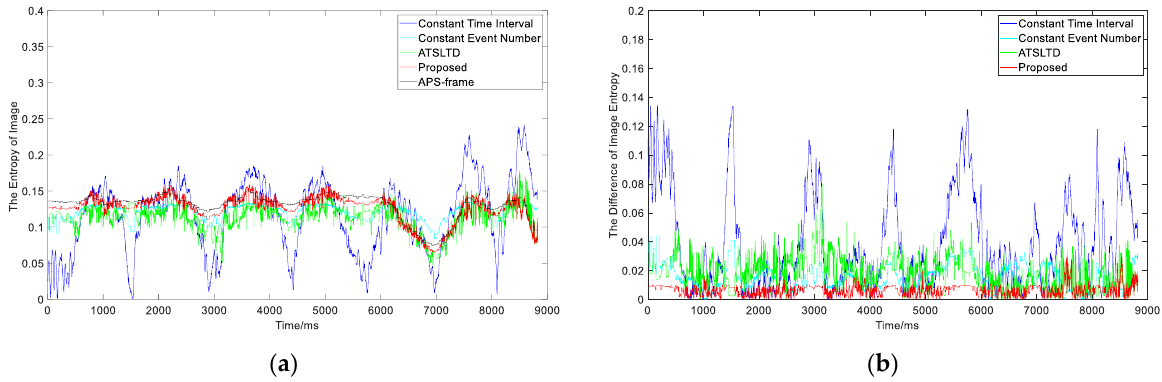
Figure 13. ( a ) The information entropy curve of virtual frame obtained by the four slicing methods and APS frame; ( b ) the difference curve between the information entropy of virtual frame obtained by the four methods and APS frame. Table 1. The mean value of the difference between the information entropy of virtual frame obtained by the four methods and APS frame.